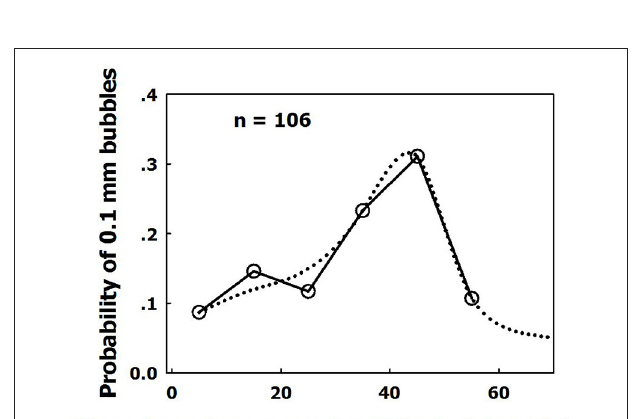
FIGURE 10 | Dispersed initiation of AHS. Frequency of initiation of active hydrophobic spots (AHS). Initiation is defined as the moment the first bubble from an AHS reaches a diameter of 0.1 mm, as a function of time from decompression. The dotted line is a suggested smooth function (taken from Arieli and Marmur, 2017 with